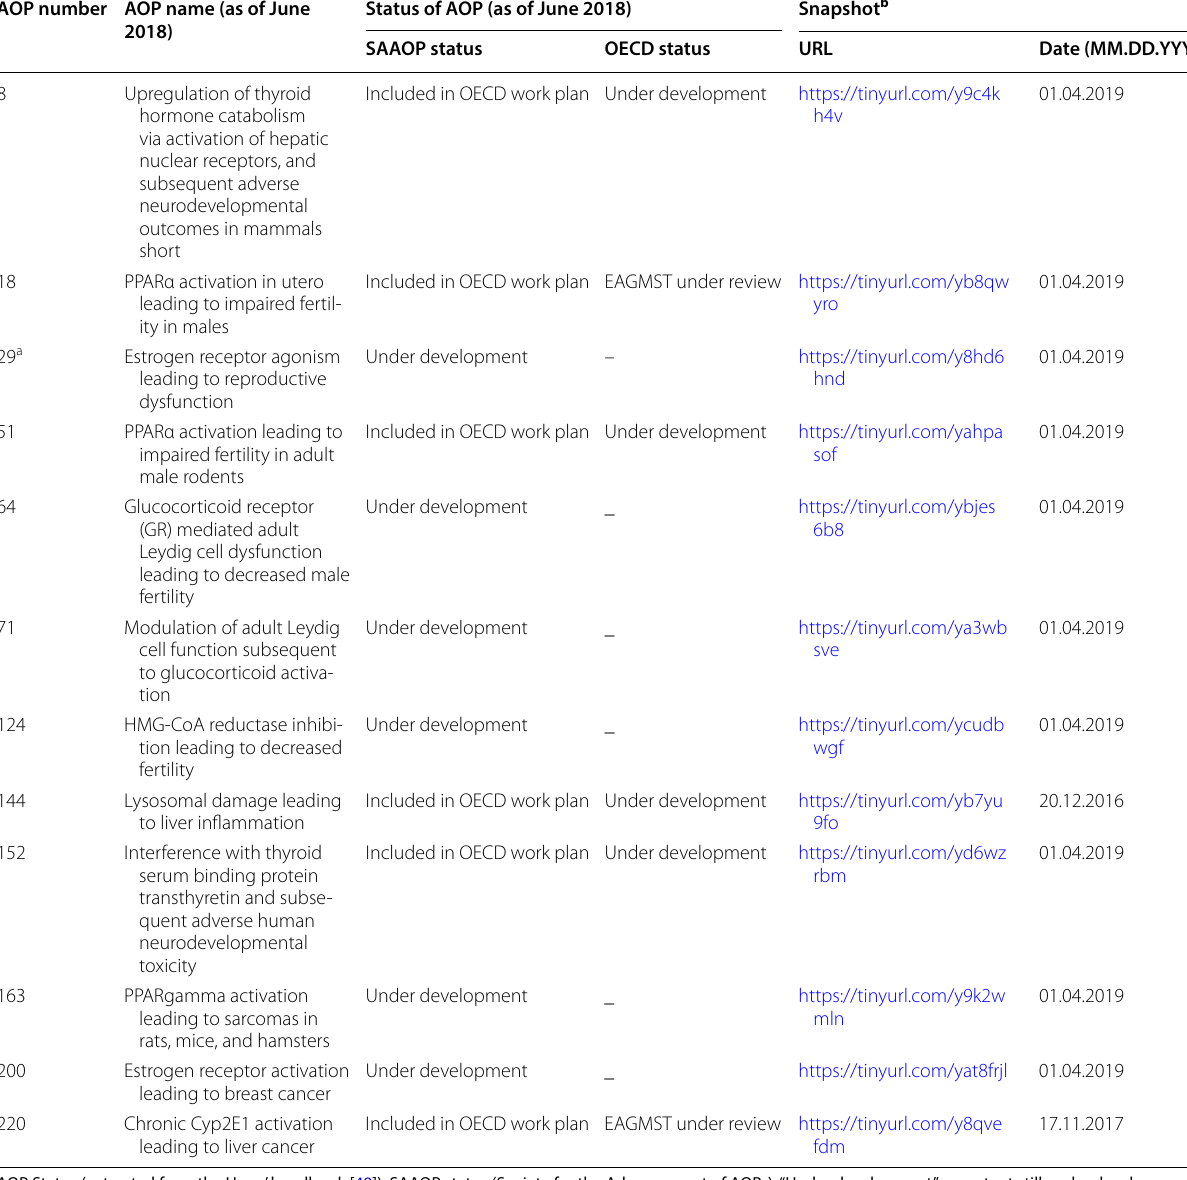
Table 4 Plausible AOPs for category I flame